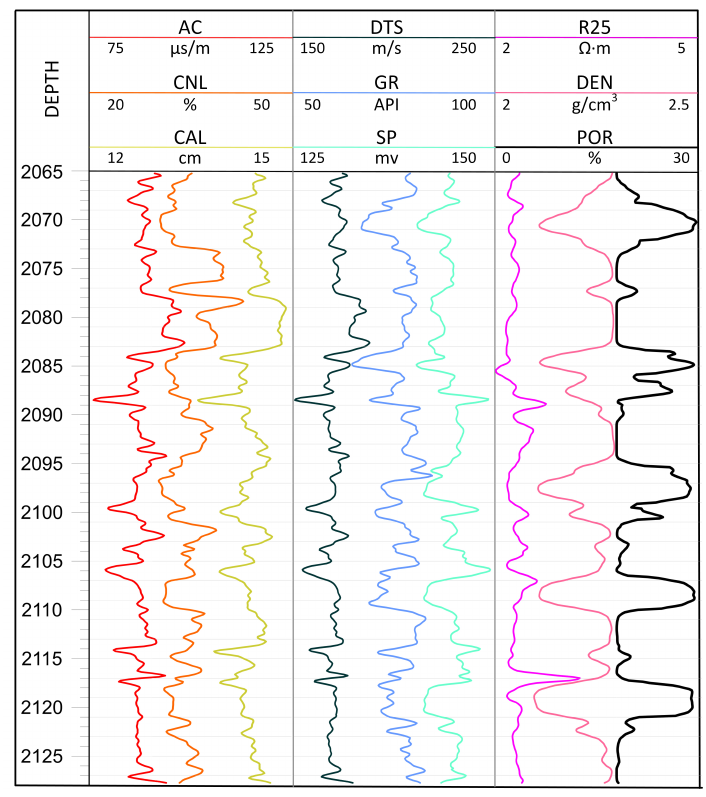
Figure 6. Well logging curve for